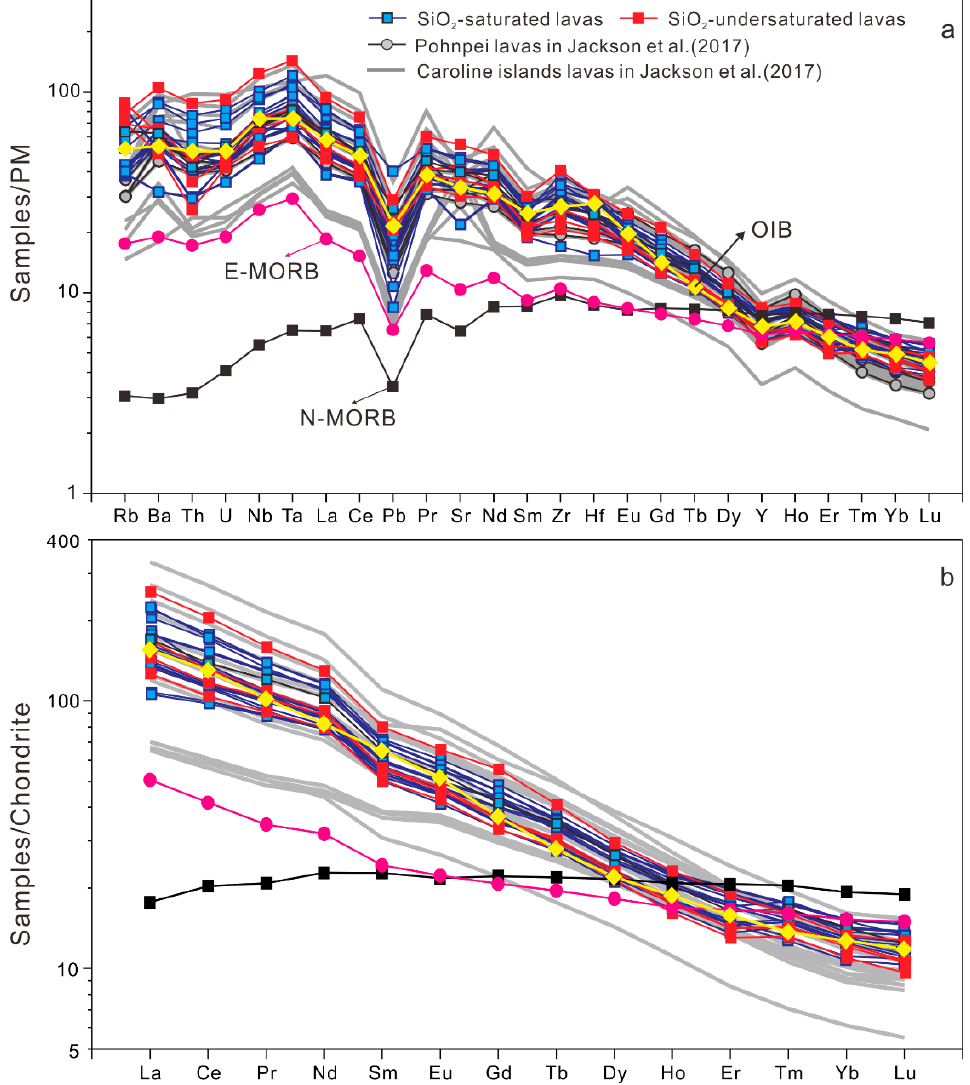
Figure 5. ( a ) Primitive mantle (PM [38])-normalized trace-element patterns and ( b ) chondrite- normalized [38] rare-earth-element (REE) patterns of Pohnpei lavas. N-MORB (normal MORB) and E-MORB (enriched MORB) trace-element data are from Gale et al. [39], and ocean island basalts (OIB) data from Sun and McDonough [40]. Data for Caroline Islands lavas (Chuuk, Pohnpei, and Kosrae) are from Jackson et al. [10].